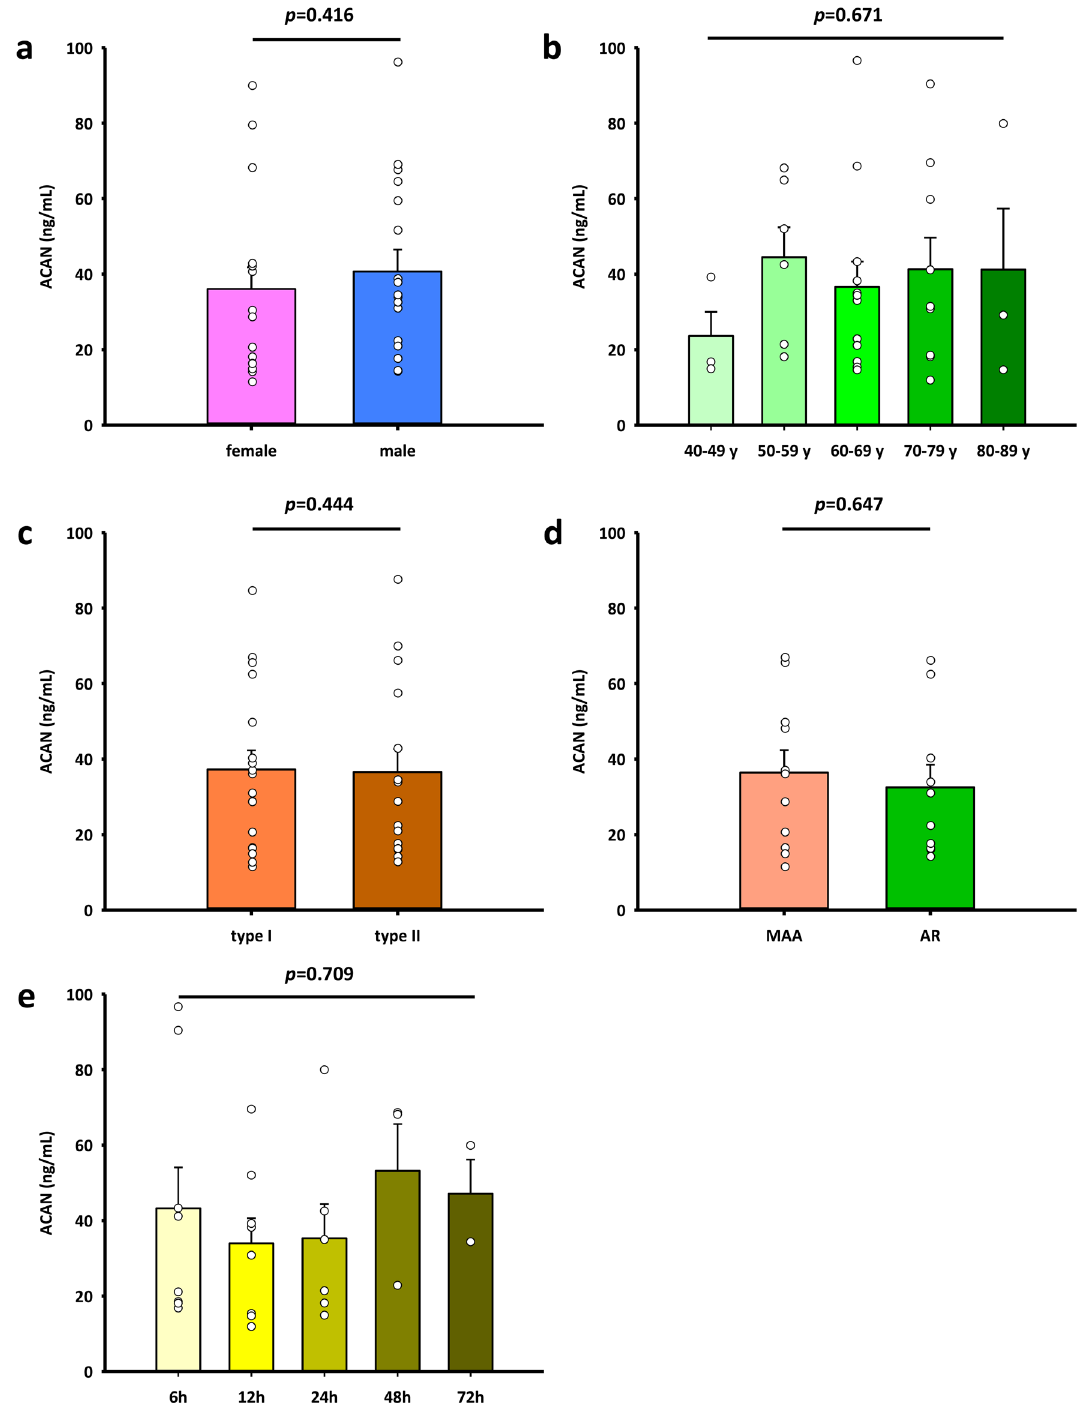
Figure 5. ACAN levels in ATAAD patients are not influenced by basic demographic parameters or the course of ATAAD. (a) ACAN levels in female (n = 15) and male (n = 18) ATAAD patients. (b) ACAN levels in ATAAD patients of different age (40–49 y, n = 3; 50–59 y, n = 6; 60–69 y, n = 12; 70–79 y, n = 9; ≥ 80 y, n = 3). (c) ACAN levels in DeBakey type I ( n = 18) or type II (n = 15). (d) Correlation of ACAN levels and site of intimal tear. MAA (n = 11), AR (n = 10). (e) ACAN levels at 6 (n = 8), 12 (n = 8), 24 (n = 6), 48 (n = 3) or 72 h (n = 2) after the onset of the disease. MAA mid-ascending aorta, AR aortic root. Values are presented as means ± SEM. Significance of difference was tested with Wilcoxon-Mann–Whitney test or one-way ANOVA